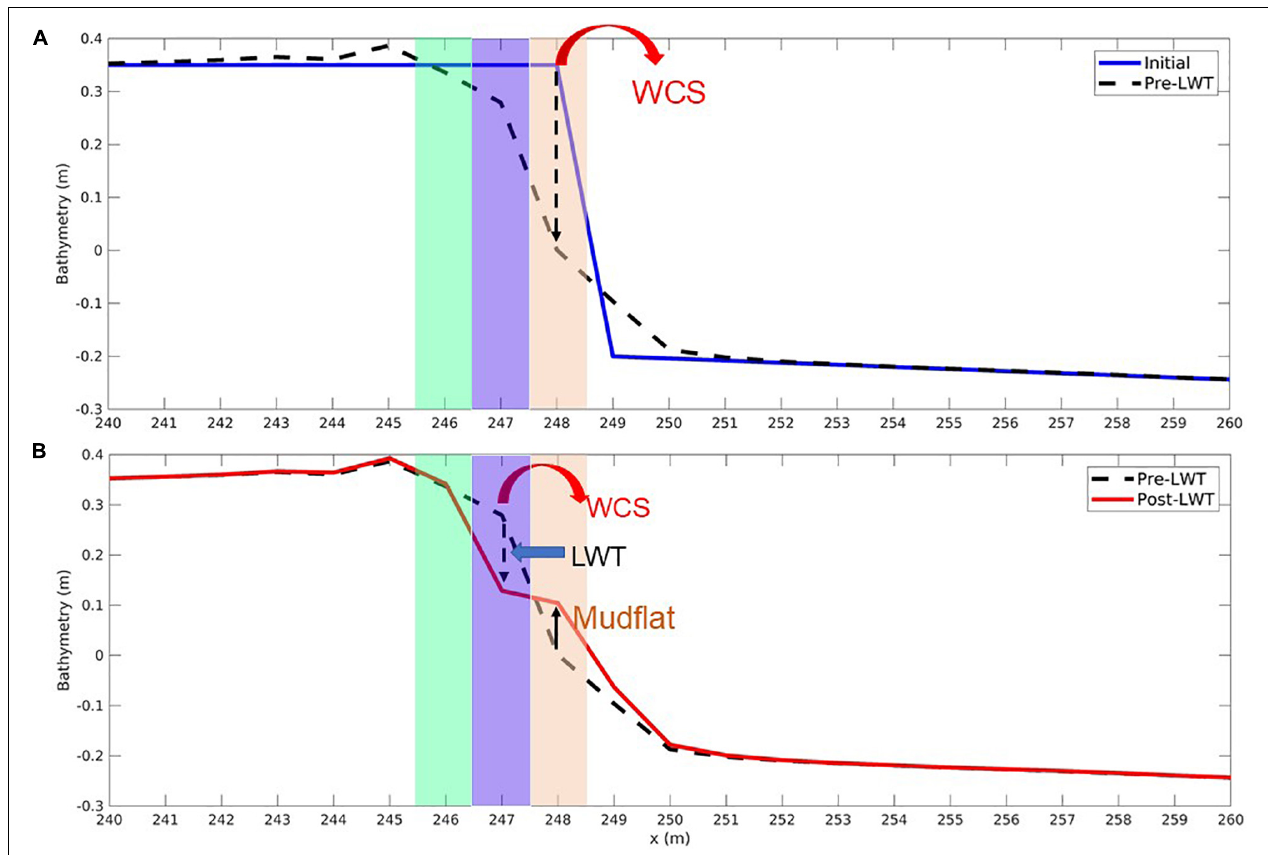
FIGURE 5 | Cross-shore profile showing topographic change from the high resolution (1 m) idealized domain: (A) Initial and final stabilized bathymetry pre-LWT following the effects of wave-current stress (WCS) only and before lateral wave thrust (LWT) is introduced (at the end of 351 days), (B) pre-LWT and post-LWT until the conversion of marsh cell to non-marsh cell (after 567 days). The shaded regions brown, blue, and green indicate the presence of marsh edges (pre-LWT at x = 248 m until 351 days, post-LWT marsh edge 1 at x = 247 m from 351 to 567 days and post-LWT marsh edge 2 at x = 246 m from 567 days until the end of the simulation set to 665 days),